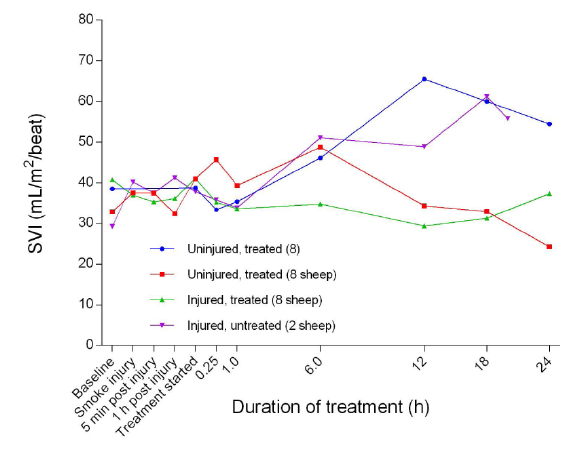
Figure 31. Systemic vascular resistance index (SVRI) (Mean ± SD error bars not shown) in smoke and non-smoke injured sheep that received extracorporeal life support as compared to that in untreated controls.